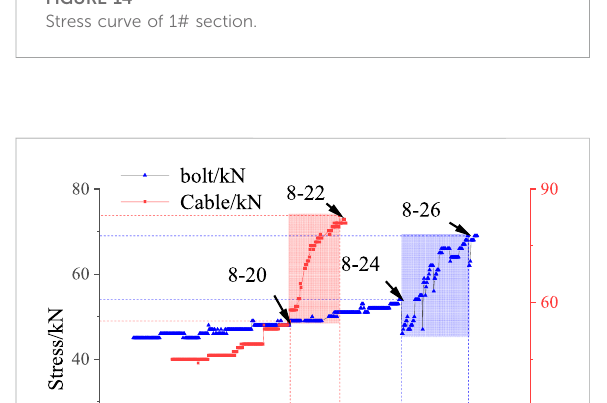
FIGURE 14 Stress curve of 1# section.